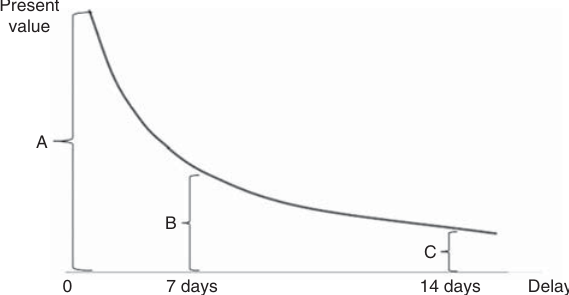
Figure 2. Displaying a discount